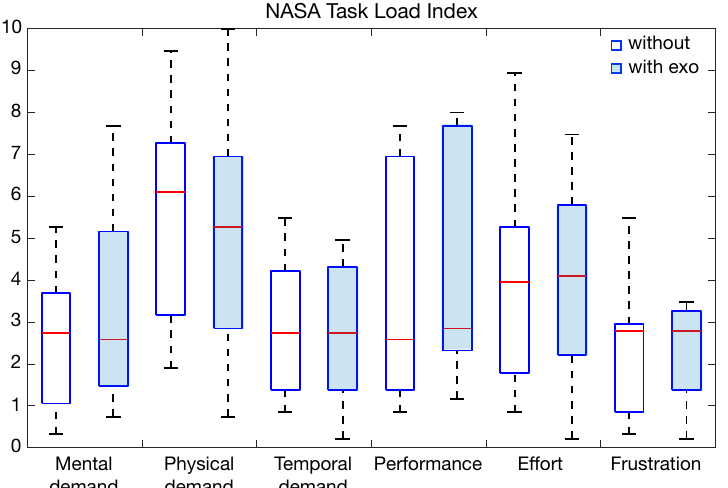
Figure 5. Boxplots of the work load assessed with the NASA-TLX questionnaire for the no-exo and exo assistance modes. The red lines represent the sample median, the distances between the tops and bottoms are the interquartile ranges. Whiskers show the min and max values. 0 = very low, 10 = very high. For the performance index, 0 = perfect, 10 =